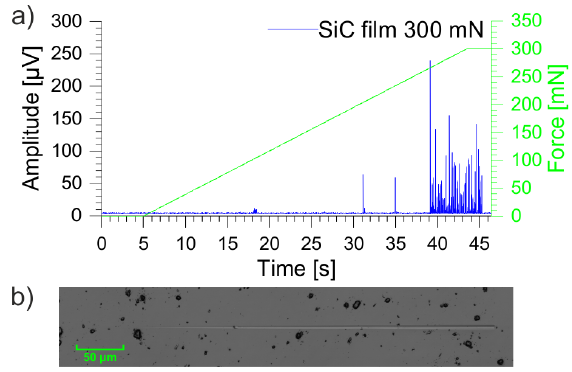
Figure 2. Scratch test performed up to 300 mN on SiC thin film: a) AE envelope b) residual scratch